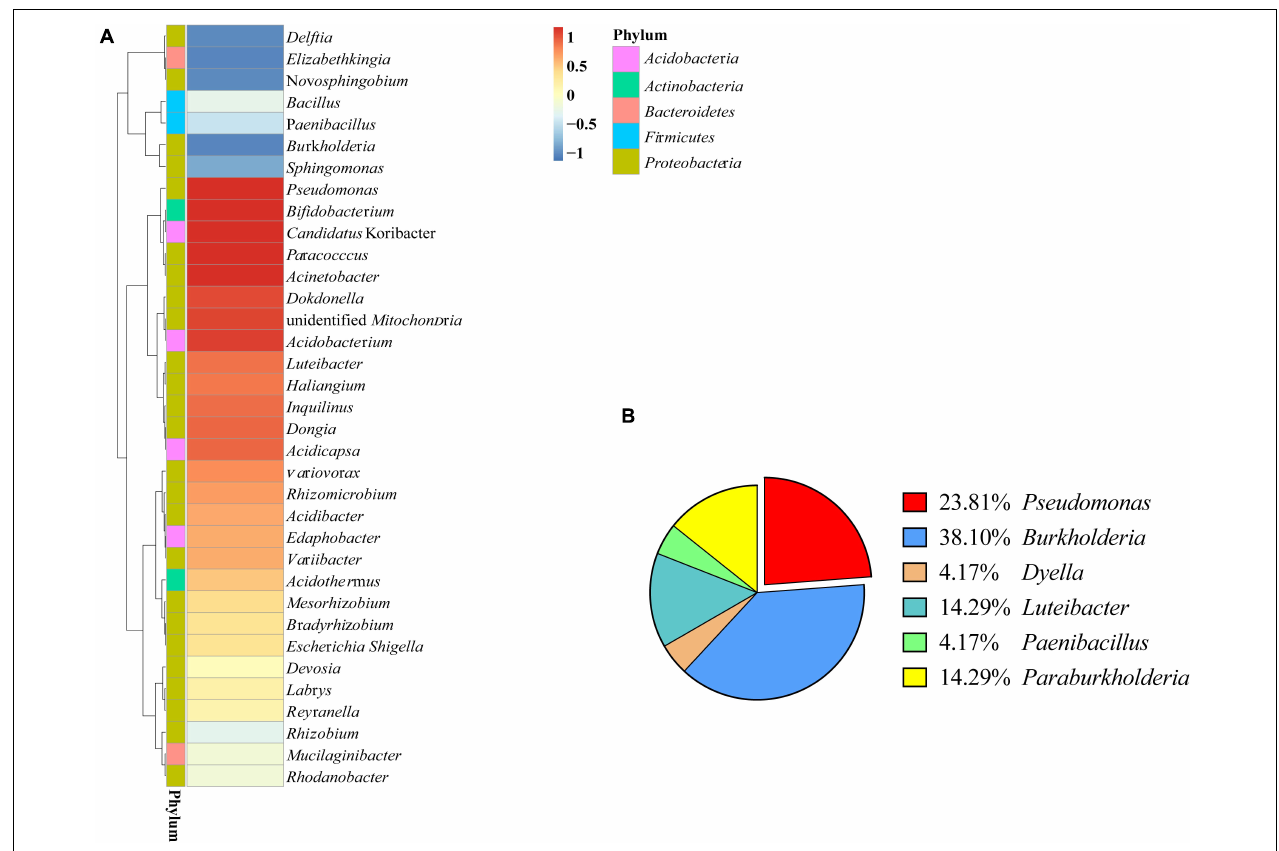
FIGURE 1 | Bacterial diversity of Polyporus umbellatus sclerotia. (A) : Bacterial abundance in P. umbellatus sclerotia. (B) : Proportion of six genera bacteria isolated from P. umbellatus sclerotia.